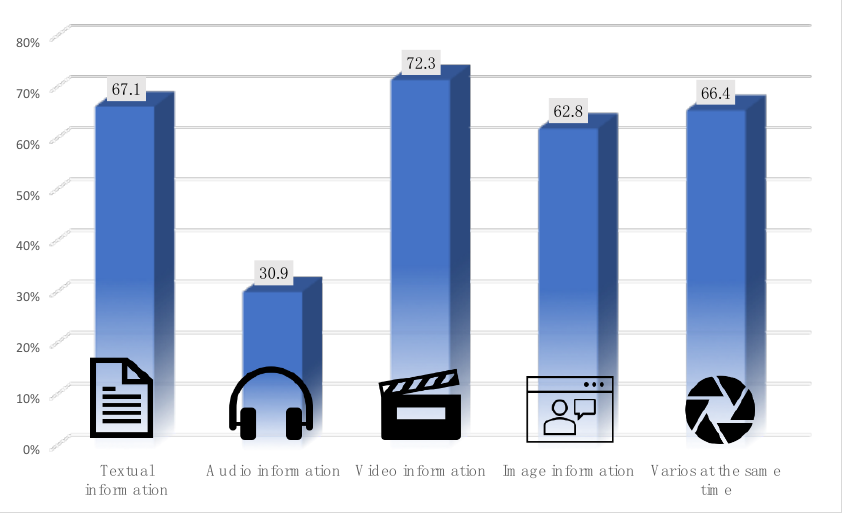
Figure 3. Graphical percentages for preferences in data types for information consumption. Own elaboration.